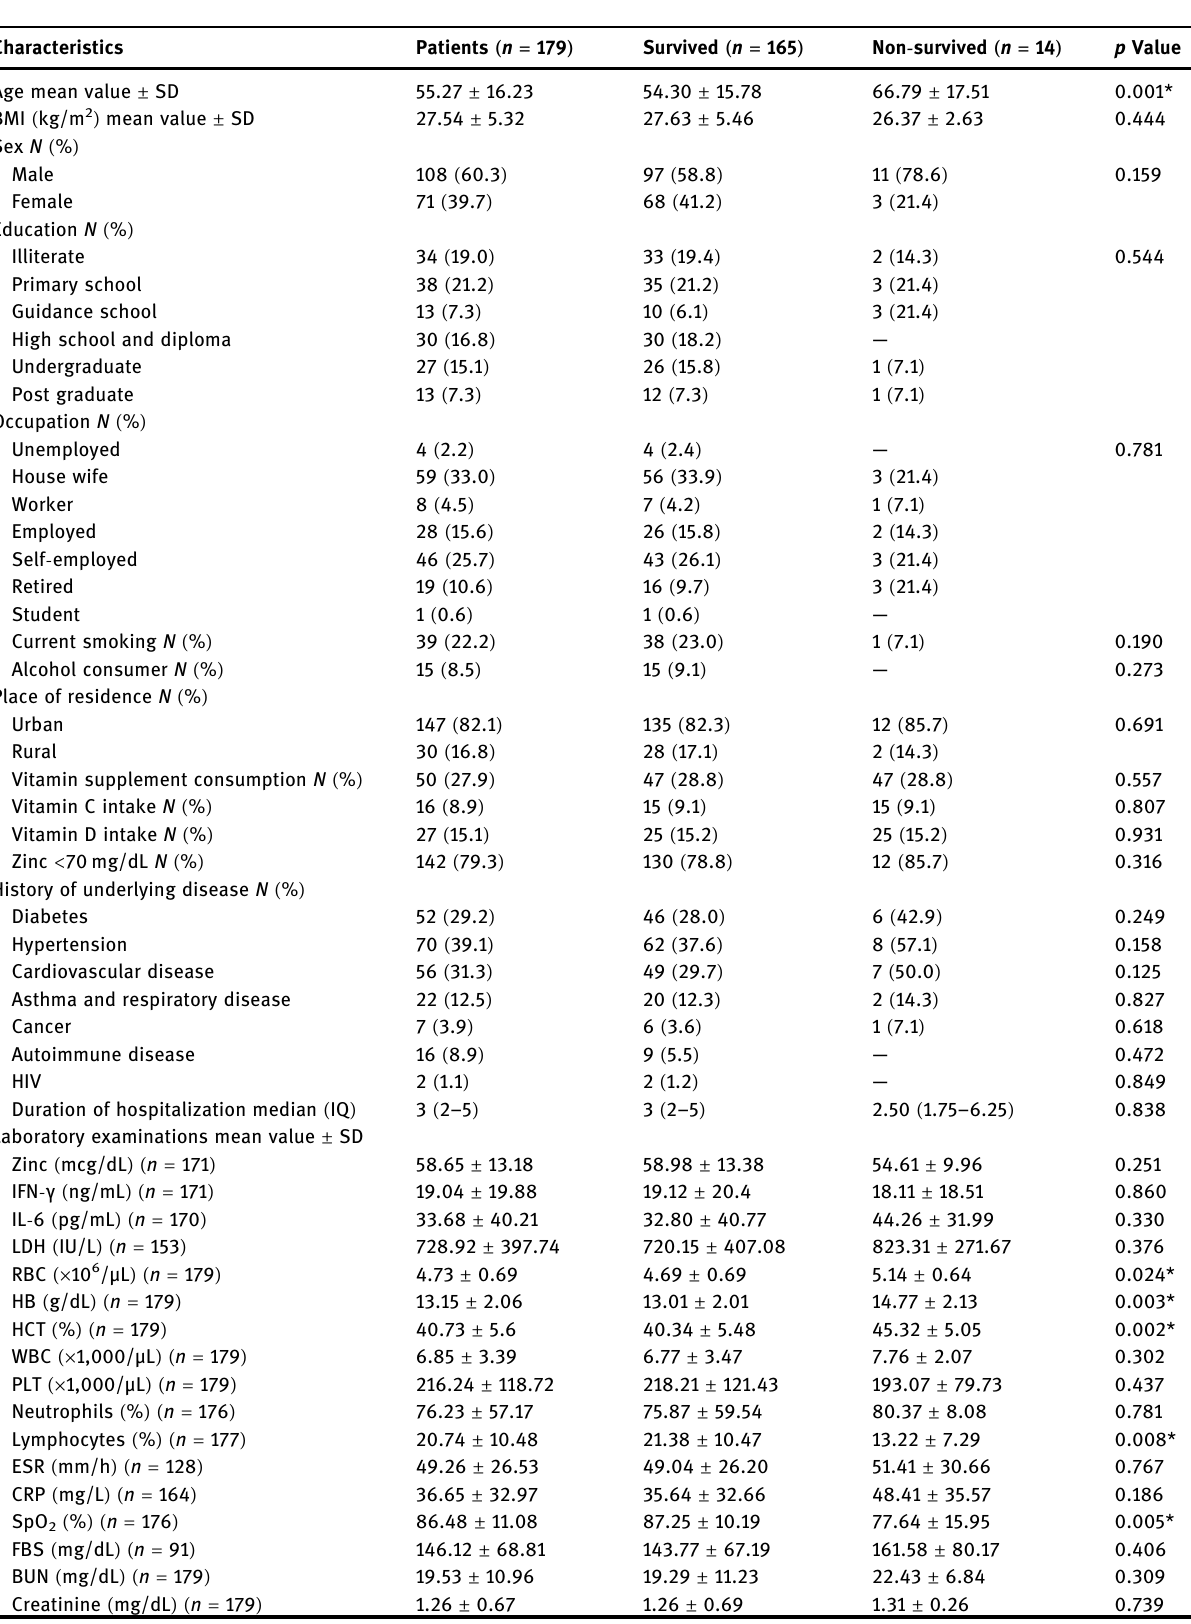
Table 1: Characteristics of patients with Covid - 19 by survival status